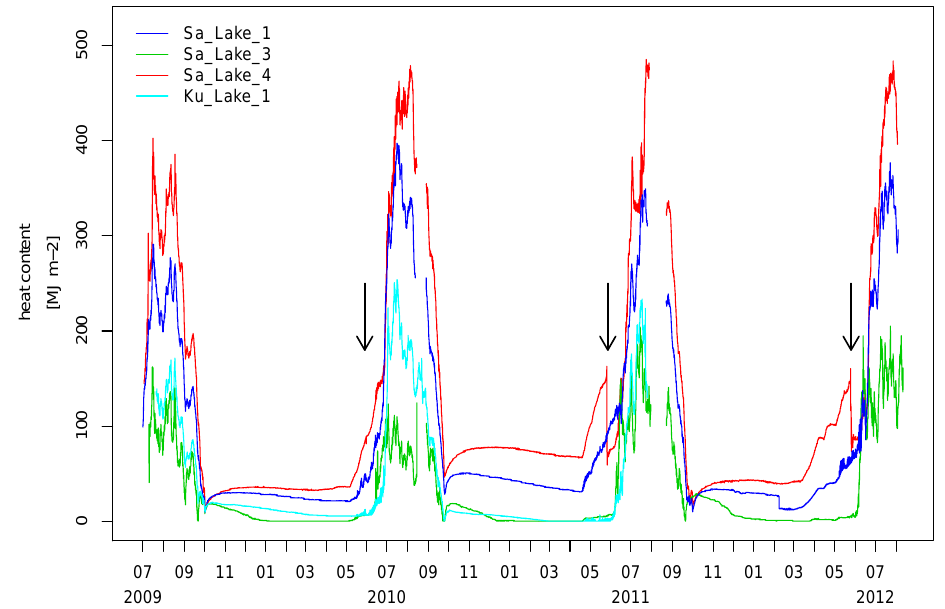
Figure 7. Sensible heat content (calculated using Eq. 1) for four lakes lakes, from July 2009 to August 2012. Arrows indicate the timing of the lake’s seasonal flooding by Lena river